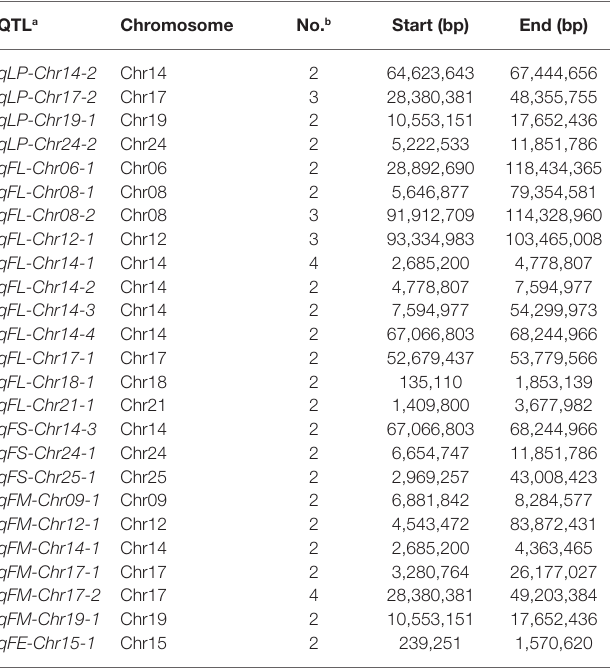
TABLE 1 | Distribution of stable QTL on chromosomes for each trait. QTL a